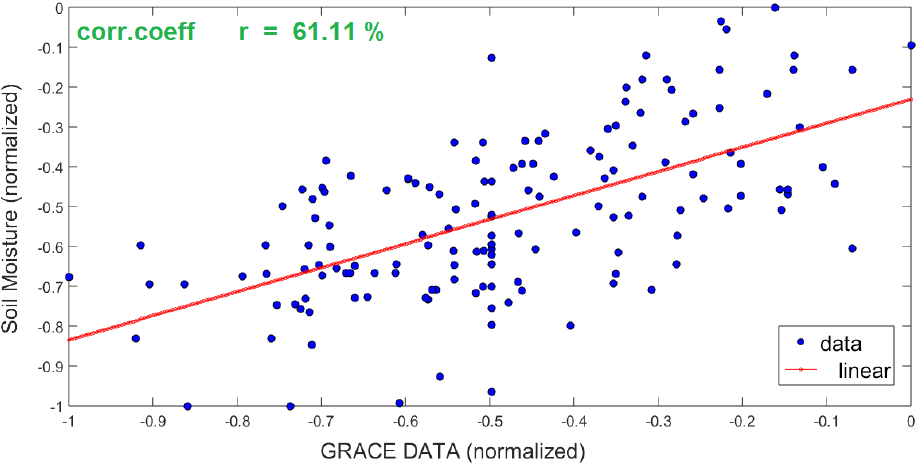
Figure 3. Comparison between average GRACE-TWS (x-axis) and the GLDAS soil moisture data (0-200 cm) (y-axis) changes axis) changes (normalized) over Sarakhs catchment from 2003 until